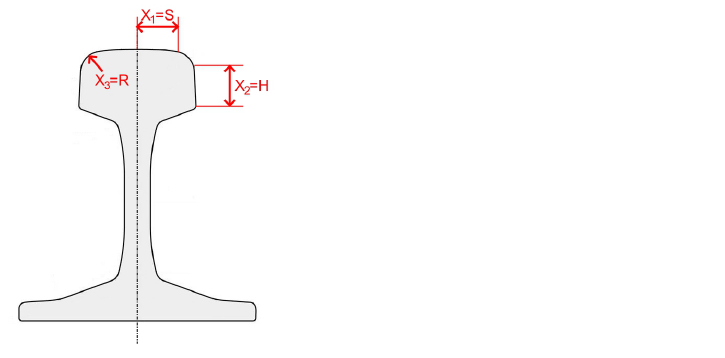
Figure 19. Representation of the parameters useful to identify the presence of a worn